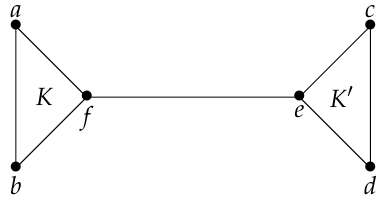
Figure 1. A chordal graph H .